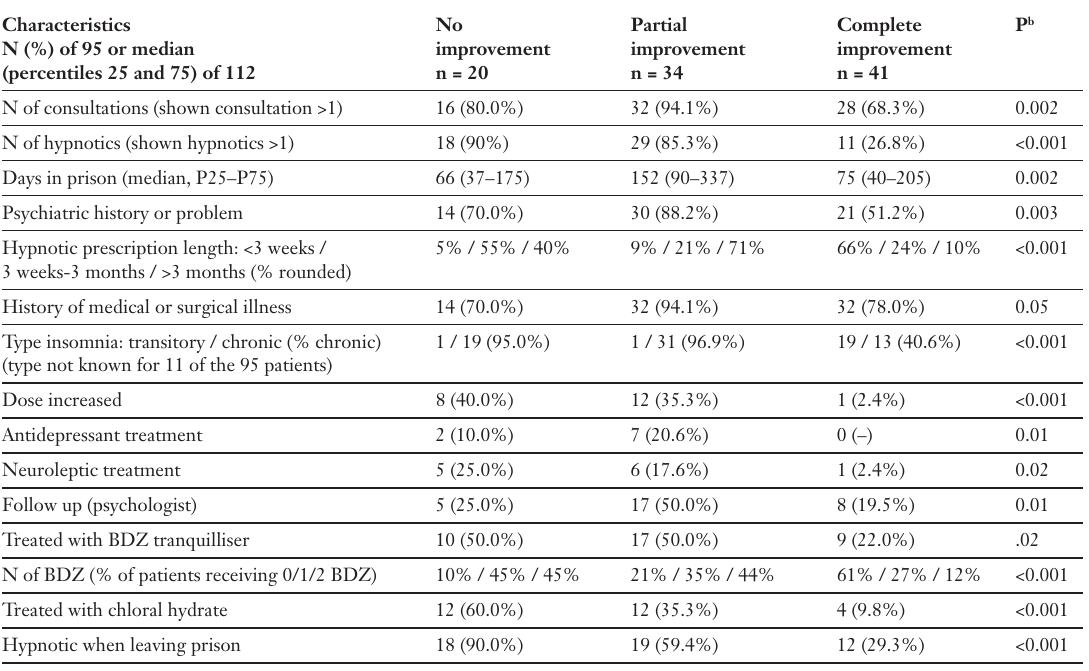
Table 4 Comparison of the characteristics of patients with no im- provement vs. partial improvement vs. complete improve- ment of insomnia among the 95 non- substance-misusing insomnia patients for which data on improvement have been found a